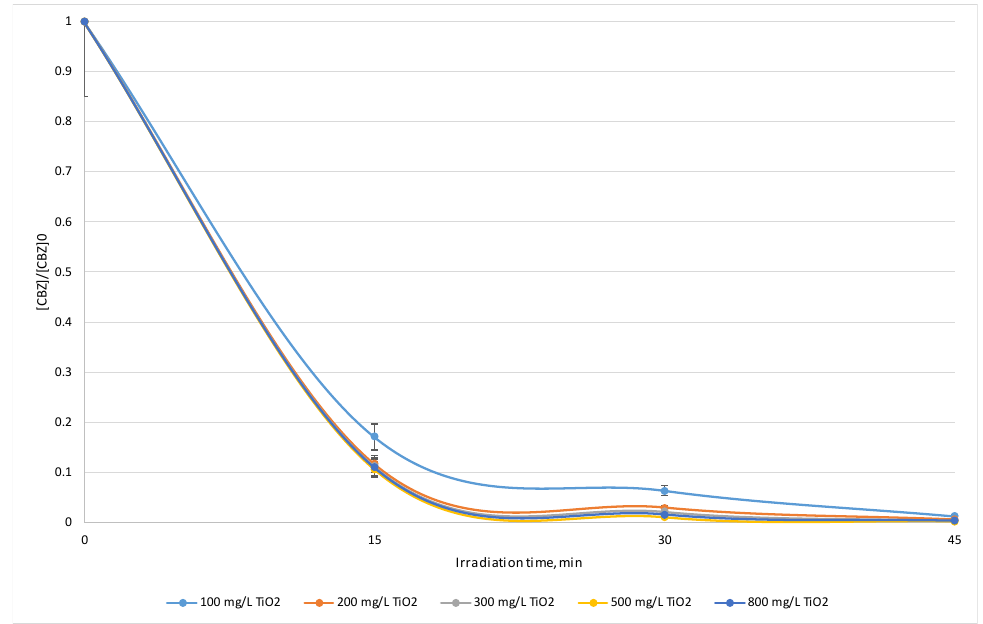
Figure 1. Normalized CBZ concentration for various catalyst (P25 Degussa) doses vs. irradiation